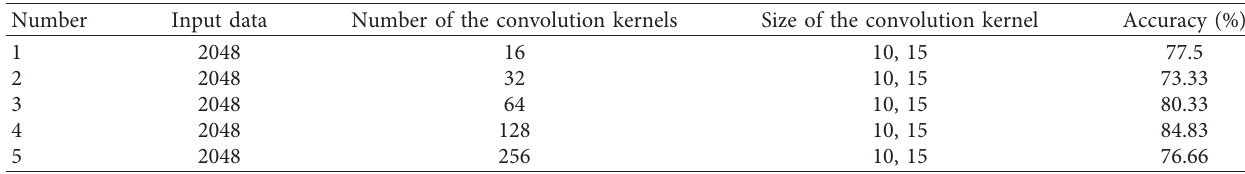
Table 3: Parameters of the selected model of DCNN.